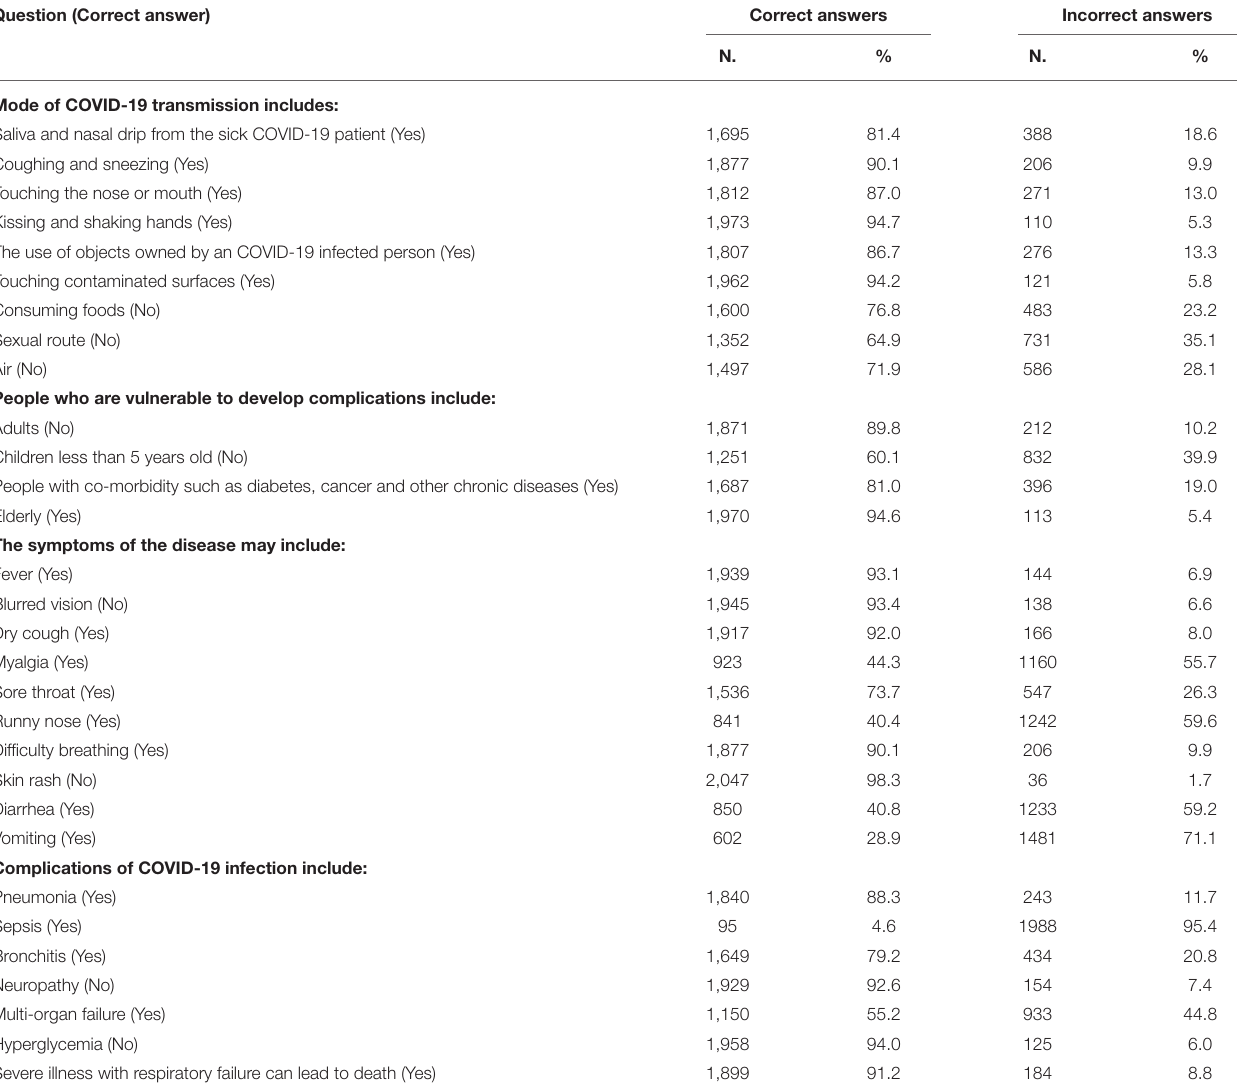
TABLE 3 | Responses about knowledge of COVID-19 transmission, symptoms, complications and people at high risk among university students in Jordan. Question (Correct